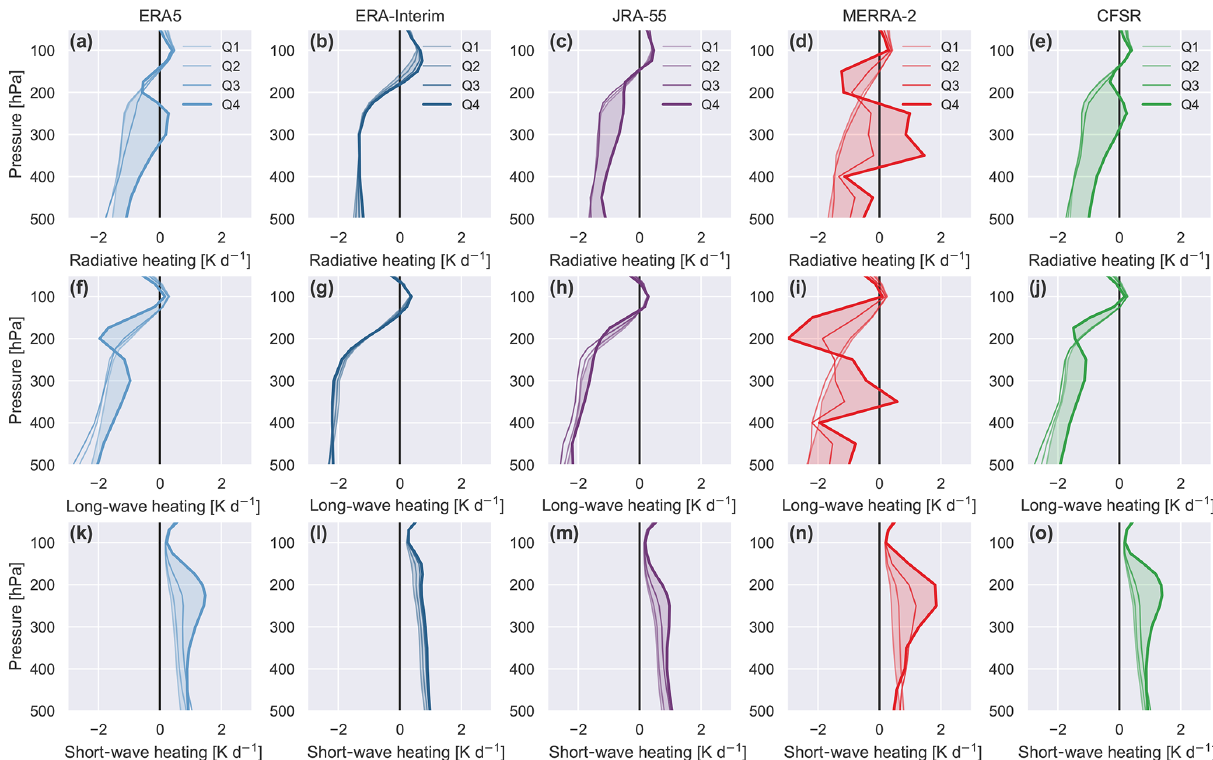
Figure 8. Composite mean profiles of daily-mean radiative heating rates as a function of pressure for the first through fourth quartiles ( Q 1 – Q 4 ) of LWCRE in the inner tropics (10 ◦ S–10 ◦ N; see also Fig. 7) based on (a) ERA5, (b) ERA-Interim, (c) JRA-55, (d) MERRA-2, and (e) CFSR during 2001–2010. Here Q 1 refers to the bottom quartile (weak long-wave CRE) and Q 4 to the top quartile (strong long-wave CRE). Total radiative heating rates (upper row; a–e ) are separated into (f–j) long-wave and (k–o) short-wave components in the lower two